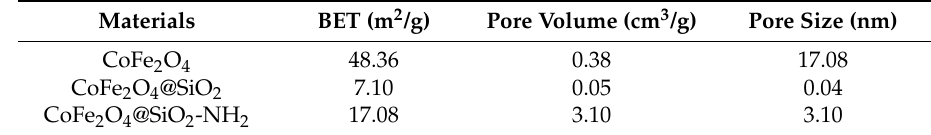
Table 1. N 2 adsorption-desorption isothermal data of as-prepared materials.